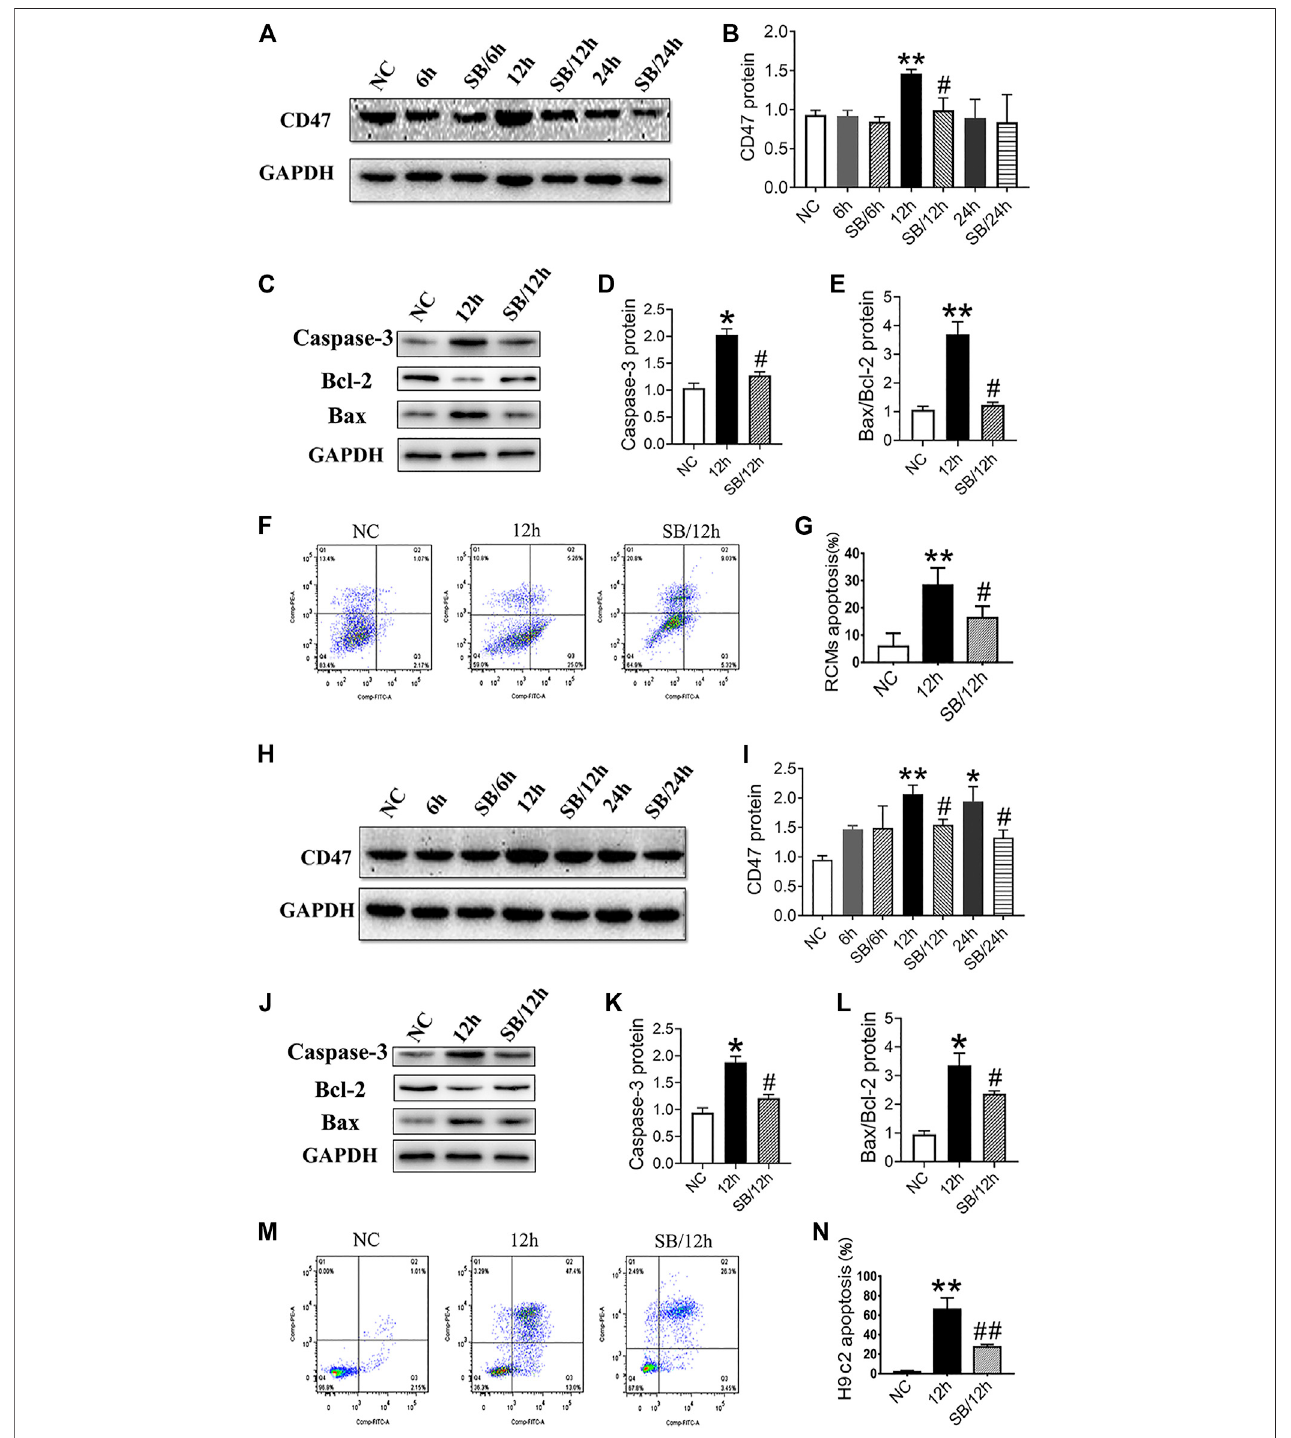
FIGURE 3 | GSK-3 β inhibition downregulates CD47 expression and apoptosis in hypoxic cardiomyocytes and H9c2 cells. Western blot analysis of CD47 expression in RCMs (A, B) and H9c2 cells (H, I) . Western blot analysis of caspase-3, Bcl-2, and Bax expressions in hypoxic RCMs (C – E) and H9c2 cells (J-L) . Flow cytometry showed a decrease in the apoptosis rate in hypoxic RCMs (F, G) and H9c2 cells (M, N) ( n (cid:2) 3/group). Data are presented as the mean ± SD. *p < 0.05, ** p < 0.01 vs. NC; # p < 0.05 vs. 12 h, 24 h, ## p < 0.01 vs. 12 h.